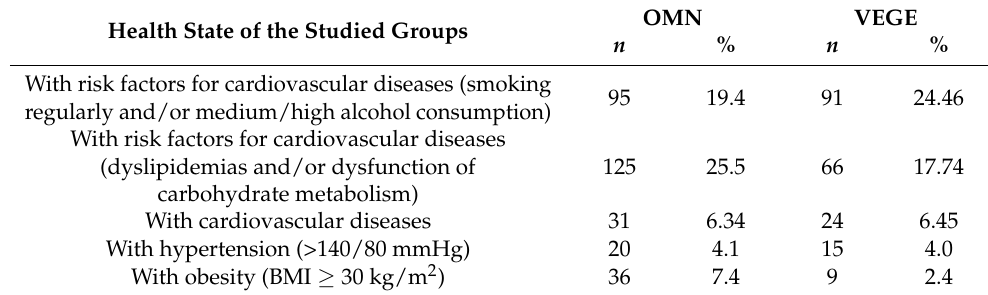
OMN VEGE n % n % 95